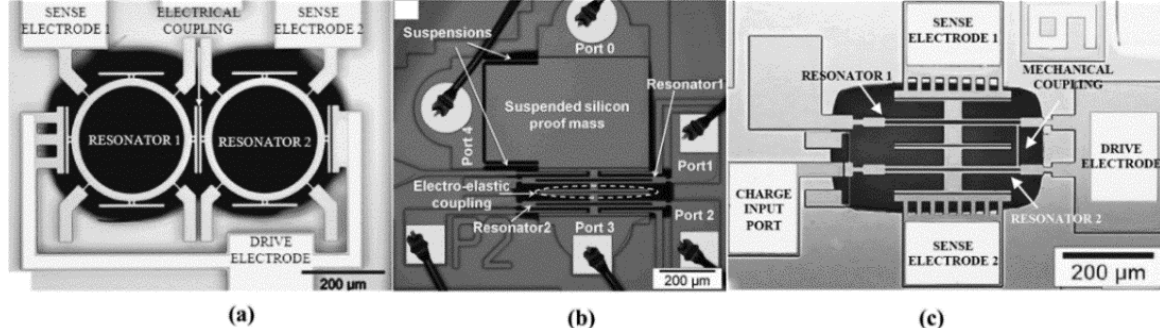
Figure 12. The Photos of electrically coupled resonators ( a ) mass sensor. Reproduced with permission from [77]. Rights managed by AIP Publishing. ( b ) displacement sensor. Reproduced with permission from [78]. Copyright © 2012, IEEE. ( c ) electrometer. Reproduced with permission from [79]. Copyright © 2010, IEEE. Table 3. Comparisons of properties of different EL-SCRB sensors with two resonators.